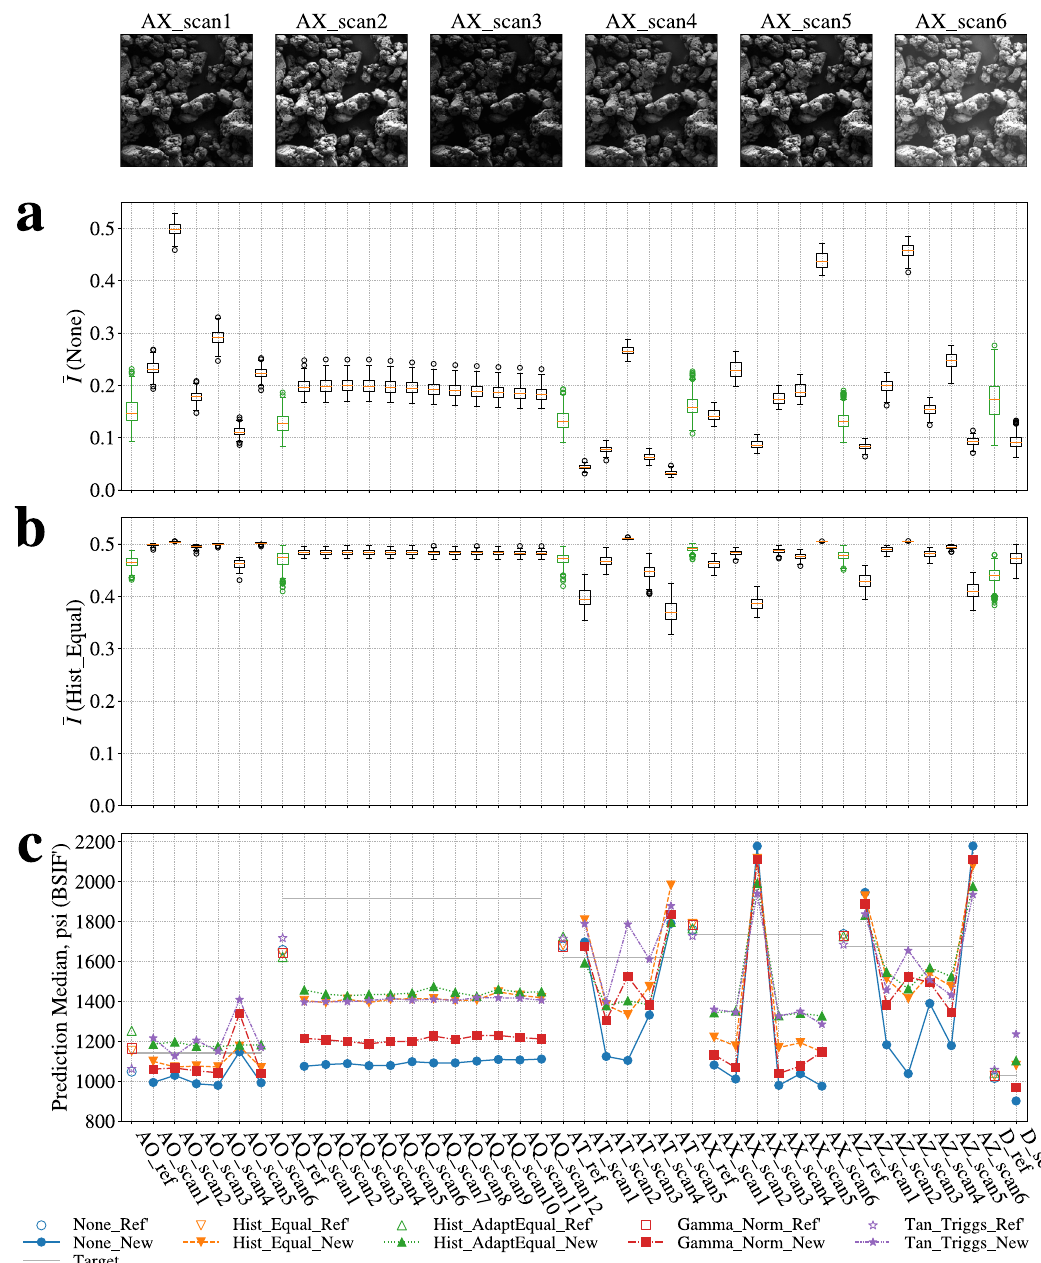
Table 1a. The clustering step of VLAD can take a prolonged time. Marginal performance improvement is not the focus of this work, so we set a